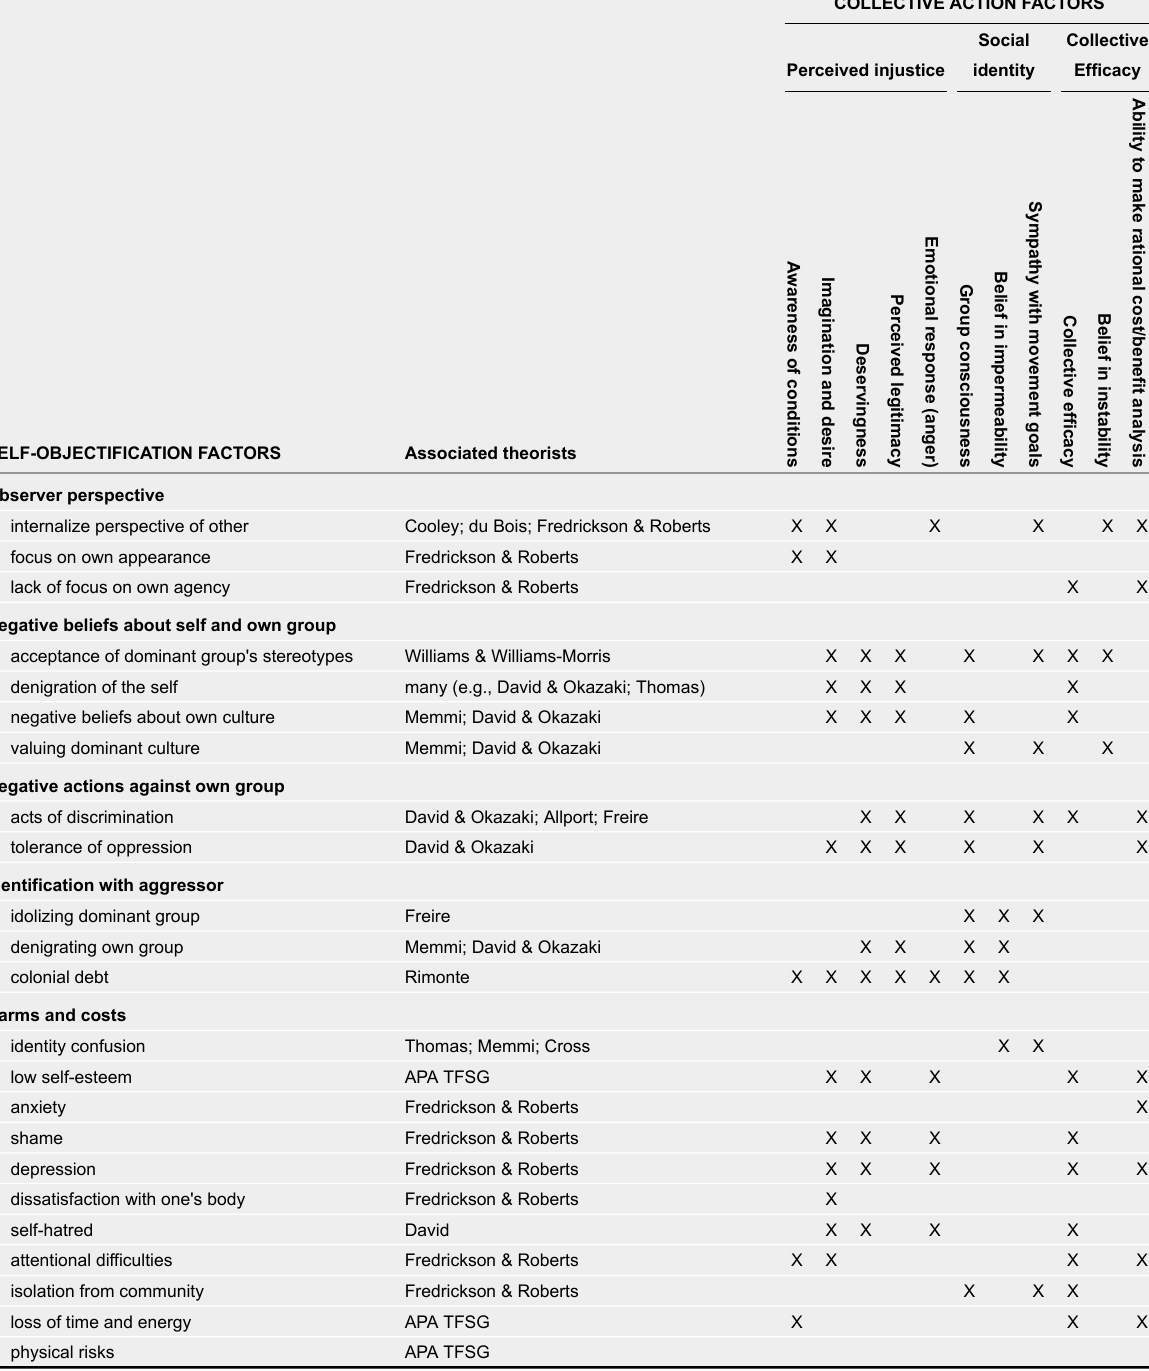
COLLECTIVE ACTION FACTORS Collective EfficacySocial identityPerceived